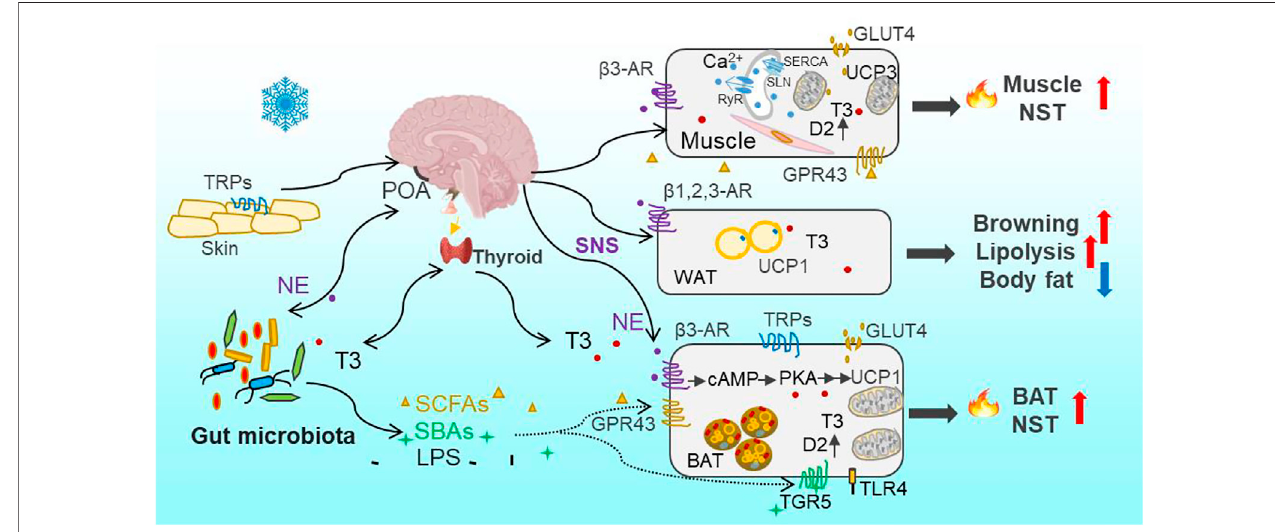
FIGURE 1 | Overview of cold-induced thermogenesis through Thermo-TRPs — SNS — gut microbiota — thermogenesis axis and thyroid — gut microbiota — thermogenesis axis. Cold is sensed by the thermosensitive transient receptor potential channels (Thermo-TRPs) on the skin and in the brain and other organs.Coldsignalistransmittedthroughthesensoryafferentnervetothepreopticarea(POA)inthehypothalamusandotherthermoeffectorefferentcircuits,andleads to the activation of the sympathetic nervous system (SNS) to release norepinephrine (NE) and stimulate mitochondrial uncoupling protein 1 (UCP1) through β 3 adrenergic receptors ( β 3-AR) and activation of PKA signaling pathway in brown adipose tissue (BAT). In parallel with the direct effect of NE on thermogenesis, the gut microbiota community is reconstructed through sensing cold signal or neuroactive signal of NE and, consequently, leads to increases in bacterial metabolites (short- chain fatty acids, SCFAs) and byproducts (secondary bile acids, SBAs). Both SCFAs and SBAs, via acting on their respective G protein-coupled receptors GPR43 and TGR5,canstimulate BATnonshiveringthermogenesis(NST). Moreover,thecirculatingbioactivetri-iodothyronine (T3)levelincreases after thebrainreceives coldsignal, and promotes obligatory (basal metabolic rate, BMR) and regulatory thermogenesis. T3-induced thermogenesis is also mediated by bacterial metabolites (SCFAs) and byproducts (such as SBAs and lipopolysaccharides, LPS). The binding of SBAs-TGR5 or LPS-TLR4 (Toll-like receptor 4) can activate UCP1 expression in BAT, and stimulate local type 2 deiodinase (D2) to induce the conversion from the prohormone thyroxine (T4) to bioactive T3 as well. The binding of NE with β 1,2,3-AR in white adipose tissue (WAT) activates lipolysis (catabolism of triglycerides) into free fatty acids as one source of fuel for BAT thermogenesis, leading to the decrease in body fat content. Cold-induced glucose uptake via glucose transporter (GLUT4) in adipocytes and muscle can also provide glucose as fuel for BAT and muscle thermogenesis. Muscle NST is mainly based on activities of sarcoplasmic reticulum ryanodine receptor (RyR)-mediated Ca 2+ -leak, sarcolipin (SLN)-activated sarcoplasmatic reticulum Ca 2+ -ATPase (SERCA), and mitochondrial UCP3 as well. SLN, via binding to SERCA, can uncouple ATP hydrolysis from Ca 2+ transportation and as a result increase heat